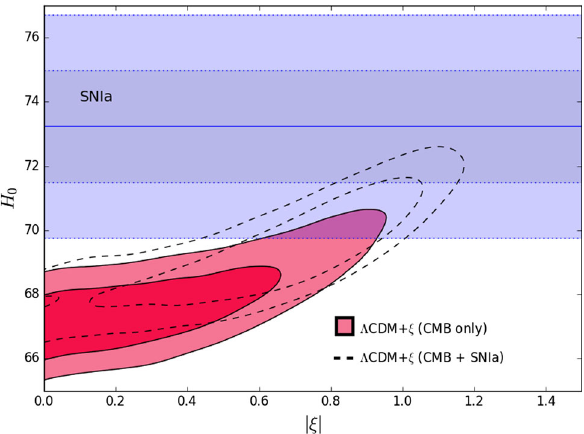
Fig. 3 Constraints on H 0 and ξ for the eight-parameter (cid:12) CDM + ξ case. Filled contours show the 68% ( dark red ) and 95% ( light red ) constraints from Planck + BICEP/Keck alone. Dashed contours show the corresponding constraints with the addition of the Riess et al. supernova data. The constraint on H 0 from the supernova data alone, H 0 = 73 . 24 ± 1 . 74 [34], is shown by the filled regions, with 1 σ limits in lavender , and 2 σ limits in